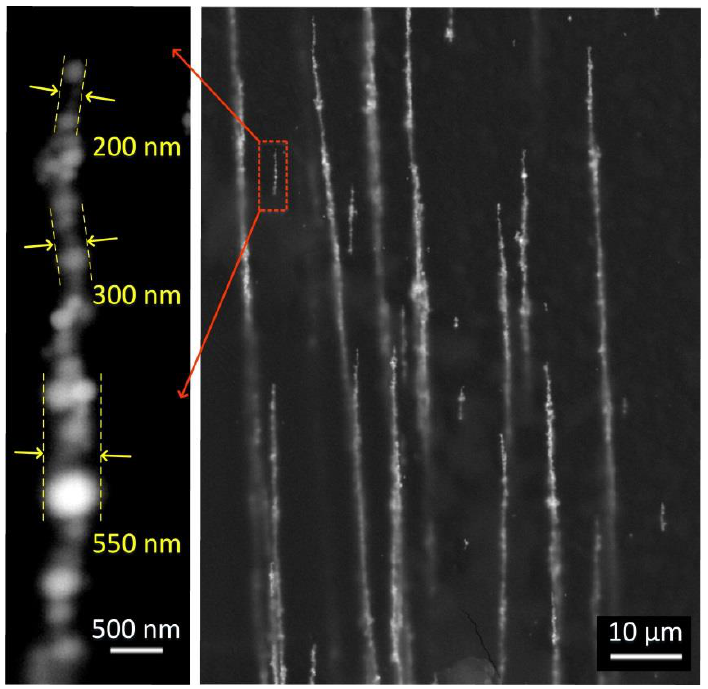
Figure 11. Typical array of Shape Memory Polymer/Nickel (SMP/Ni) chains with 1% volume fraction of sub-micro nickel particles.